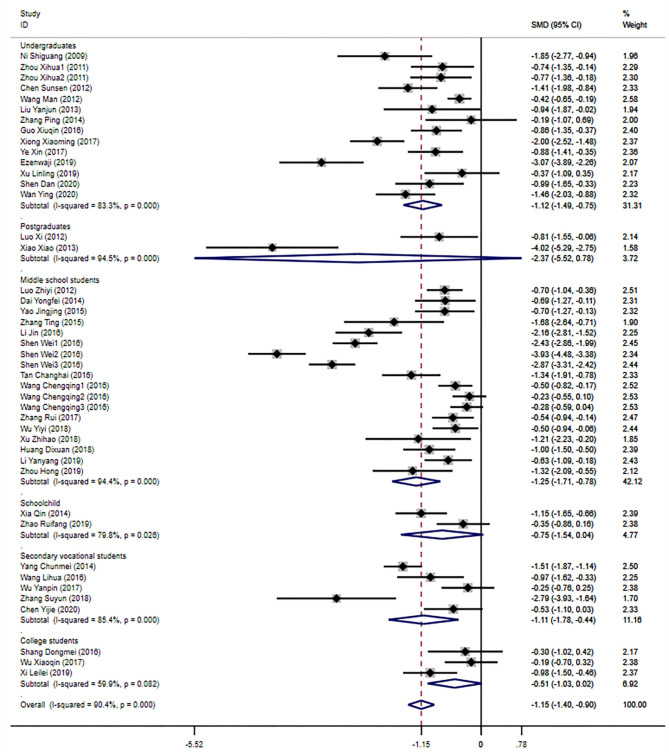
Overall analysis and subgroup analysis based on educational background.